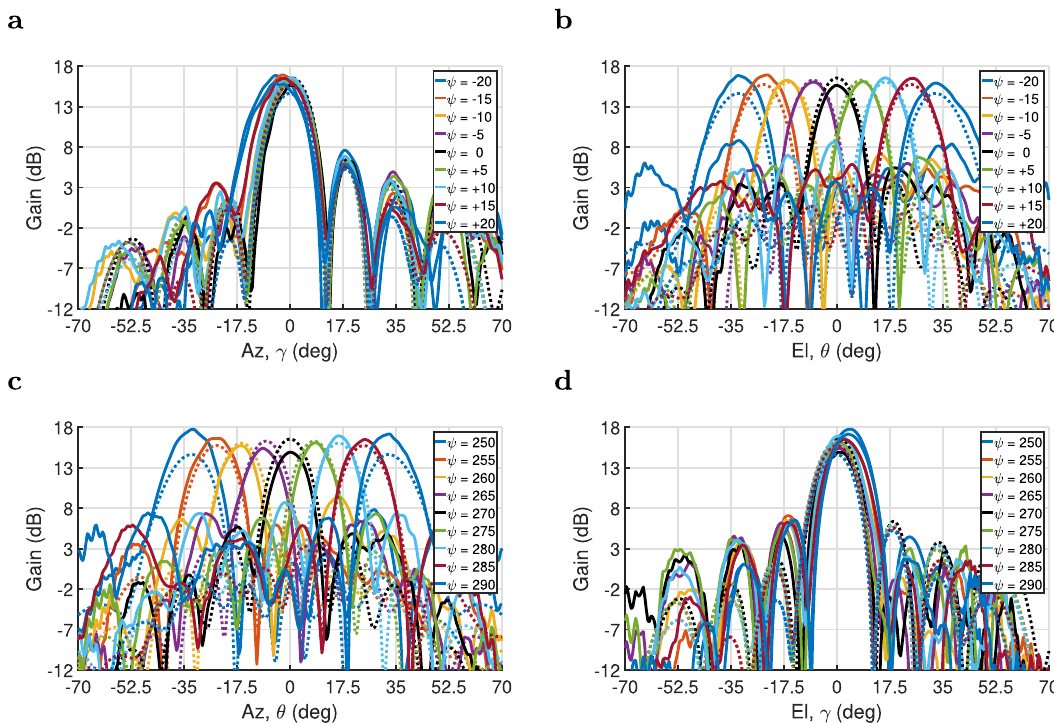
Fig. 6 Single-beam measurement. a , b Comparison between the measured (solid) and full-wave simulated (dotted) realized gain patterns (dB) at 13.1 GHz, along the a Az and b El directions for the measurement, and along the a E -plane and b H -plane for the simulation, for various values of ( ψ ), when only side A is excited. Successful electronic scanning is observed for the generated pencil beams in the El plane. c , d Comparison between the measured (solid) and full-wave simulated (dotted) realized gain patterns (dB) at 13.1 GHz, along the c Az and d El directions for the measurement, and along the c H -plane and d E -plane for the simulation, for various values of ( ψ ), when only side B is excited. Successful electronic scanning is observed for the generated pencil beams in the Az plane.